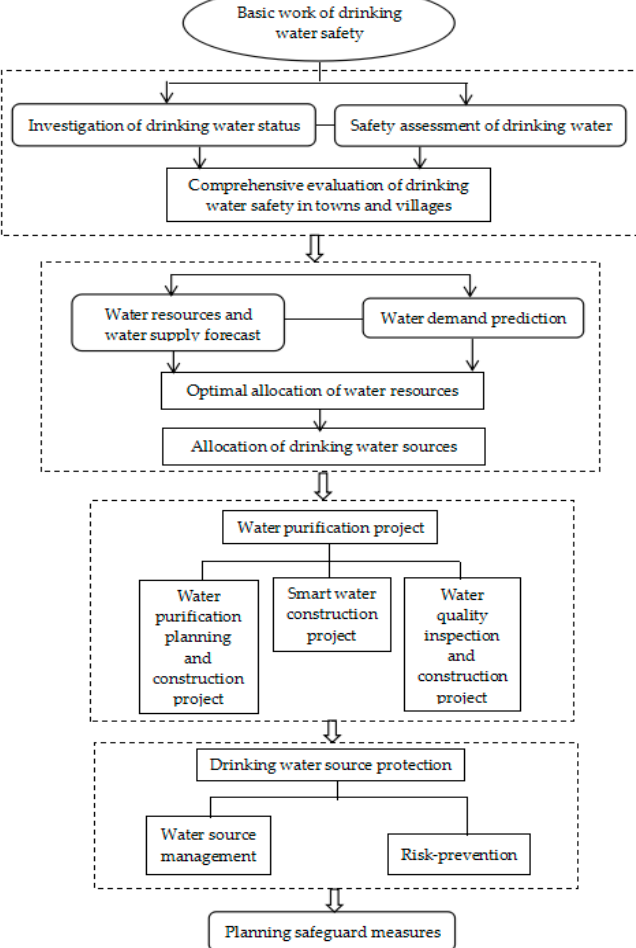
Figure 1. Technical roadmap of the study